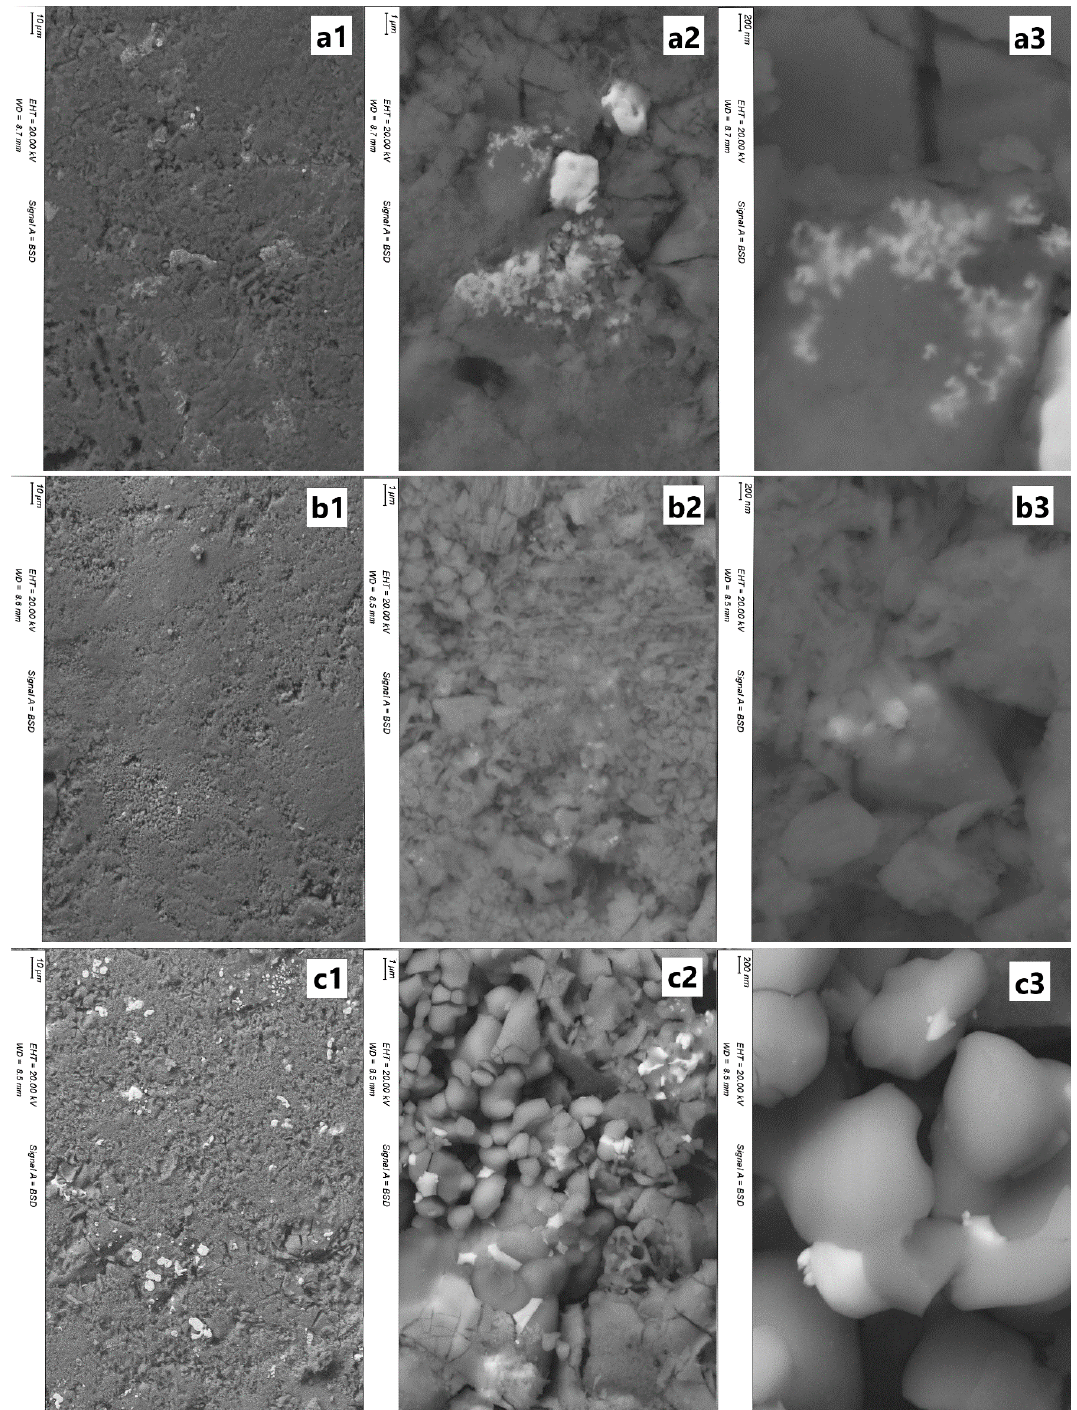
Figure 5. Electron backscattered SEM images showing the metallic silver particles in the samples. ( a ) 25Ag-400; ( b ) 25Ag-700, and ( c ) 100Ag-700 samples using 1: × 500, 2: × 5000, and 3: × 20000 magnifications.